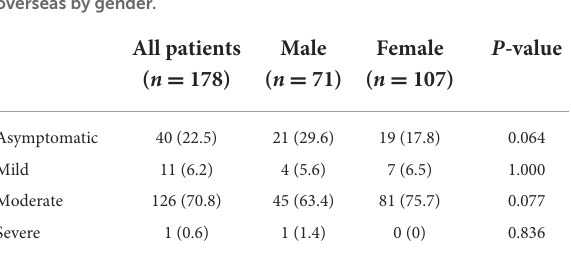
TABLE 3 Distribution of disease severity of infected subjects from overseas by